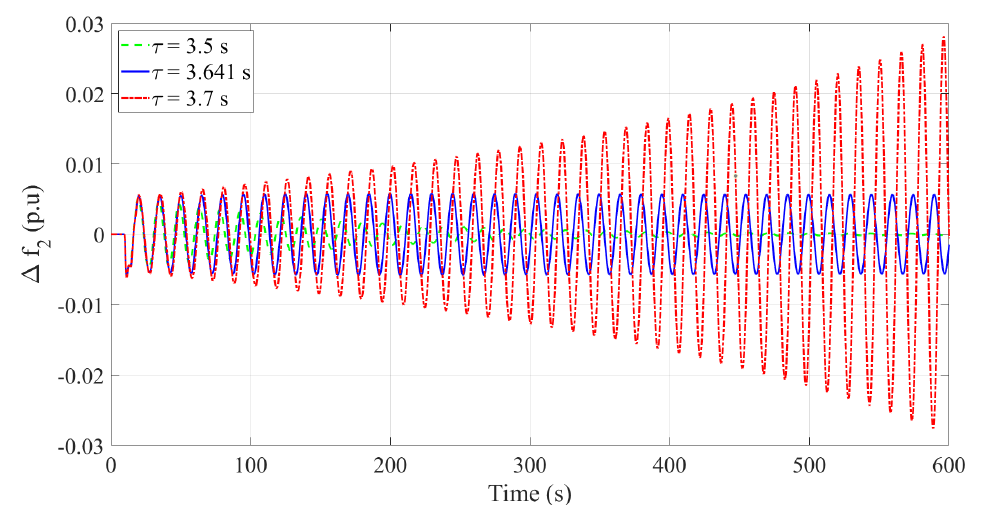
Figure 11. Frequency deviation for LFC − 2: ∆ f 2 , was measured while using K P = 0.2 and K I = 0.4. The percentage inaccuracy while employing the simulation-based DM is 0.000%.